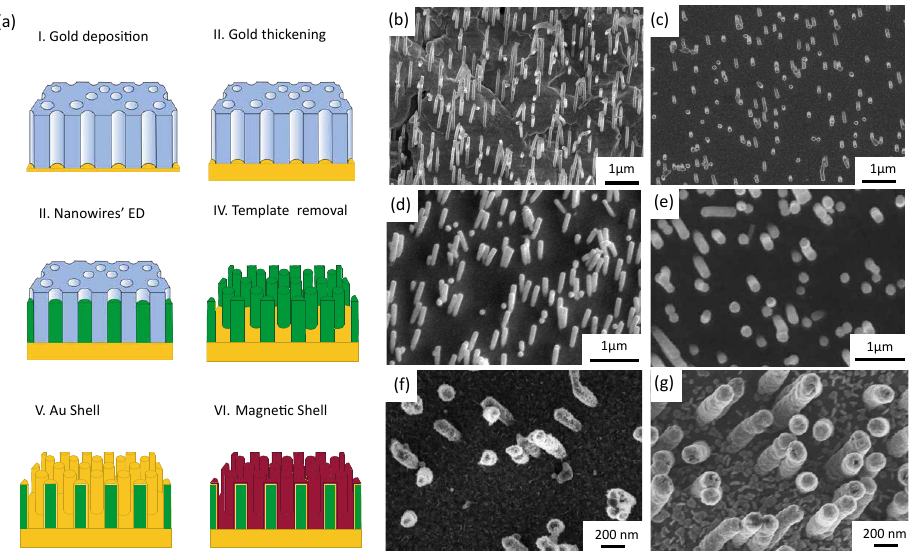
Figure 1. ( a ) Scheme of the steps followed to grow core–shell NWs. ( b – g ) SEM images of the samples at different stages of elaboration: FeNi ( b ) and Co ( c ) NWs after dissolution of polycarbonate membrane. FeNi ( d ) and Co ( e ) NWs covered by a shell of Au. FeNi/Au ( f ) and Co/Au ( g ) NWs after the growth of the Co and FeNi shell,